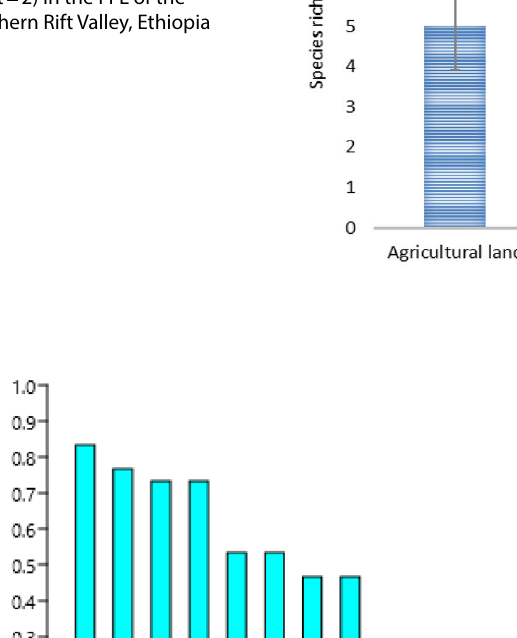
Fig. 2 The mean species rich- ness of carnivores and 95% confidence interval between land-use types (number of sur- veyed sites were wetland = 4; forest = 12; grassland = 6; agricultural land = 6; settle- ment = 2) in the FFL of the Southern Rift Valley, Ethiopia